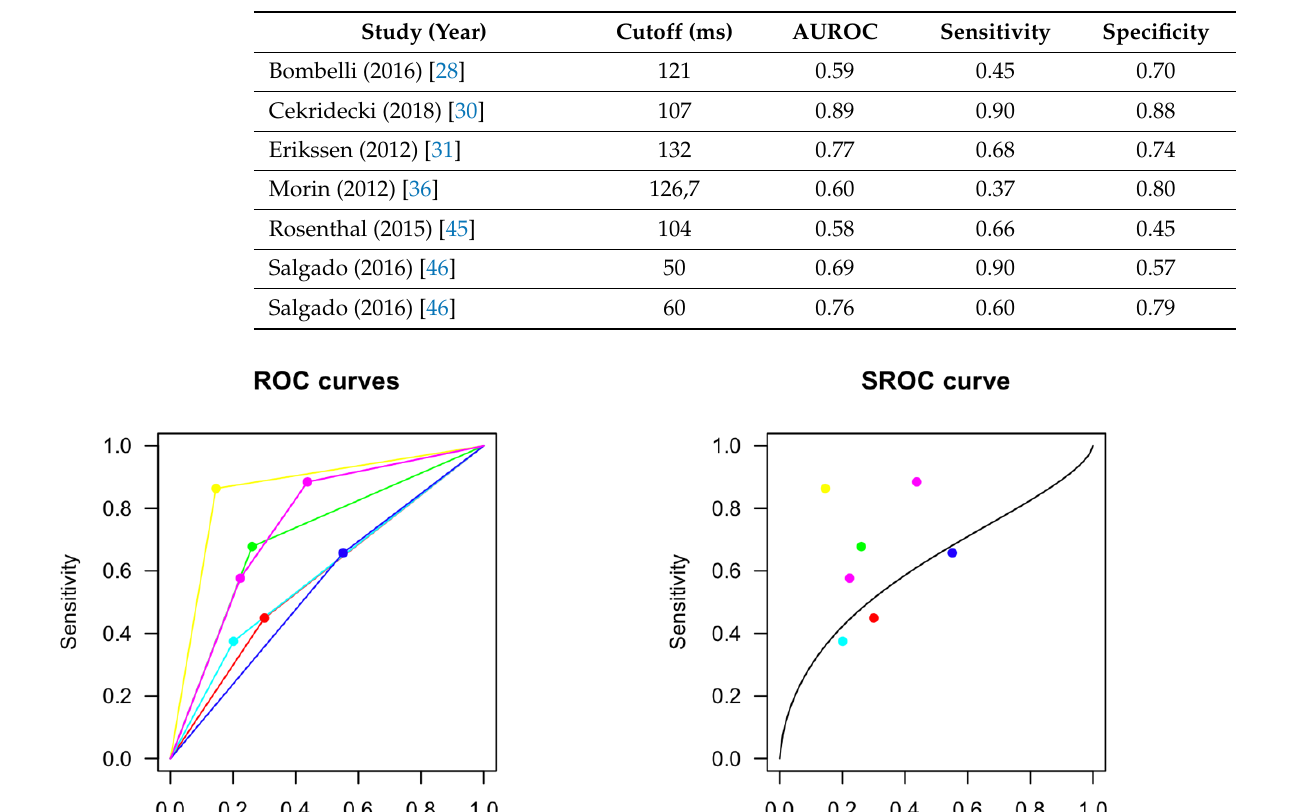
Table 2. List of studies reporting area under the receiver operating characteristics (AUROC) curves to predict all-cause death by Tpeak-Tend interval.